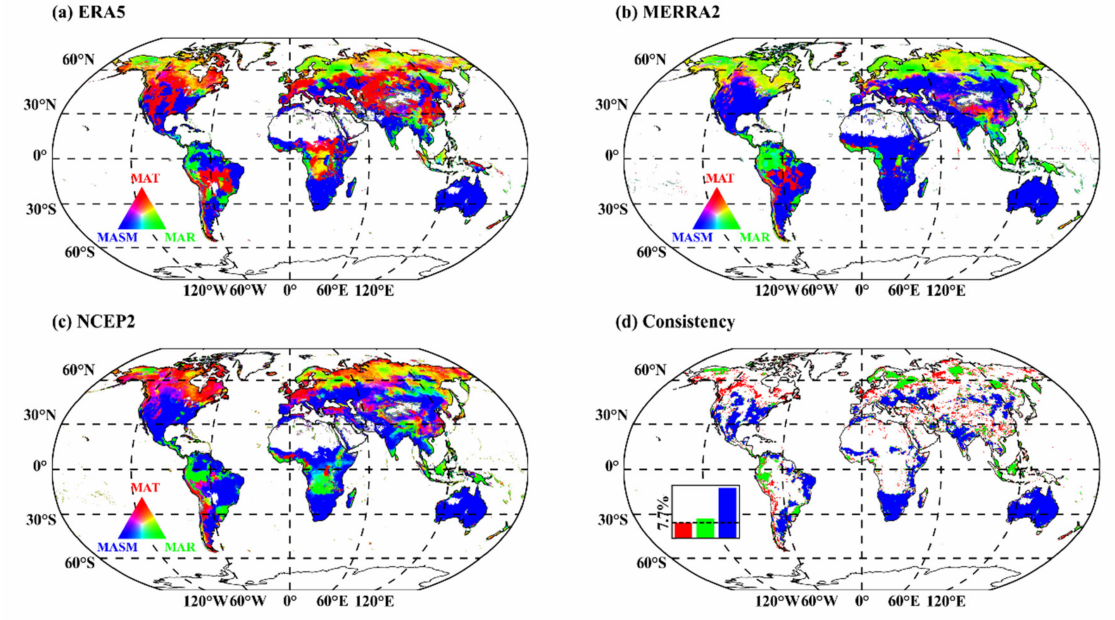
Figure 9. Spatial patterns of the effect of MAT, MAR, and MASM derived from ERA5 ( a ), MERRA2 ( b ), and NCEP2 ( c ) on the changes in NPP and their spatial consistencies ( d ) from 2001 to